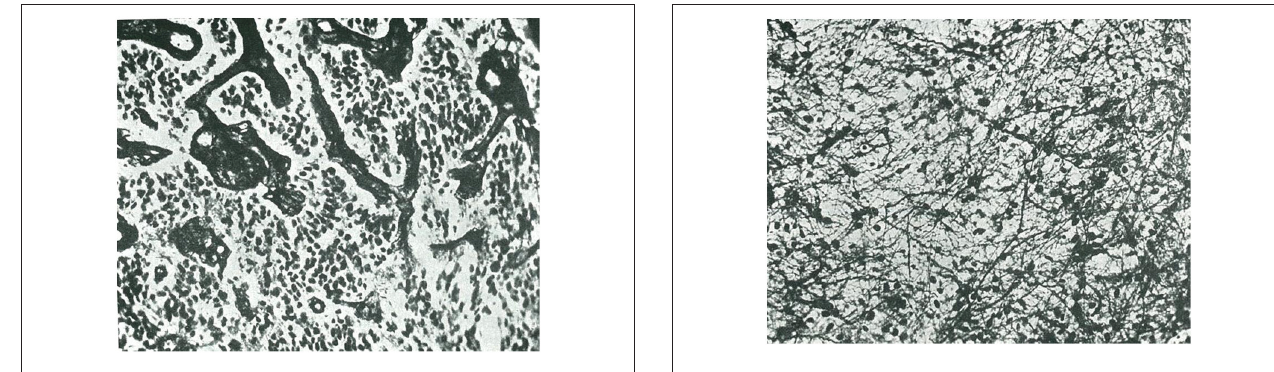
FIGURE 2 | Isomorphic glioblastoma, as termed by Rio-Hortega (taken from Río-Hortega, 1933a).